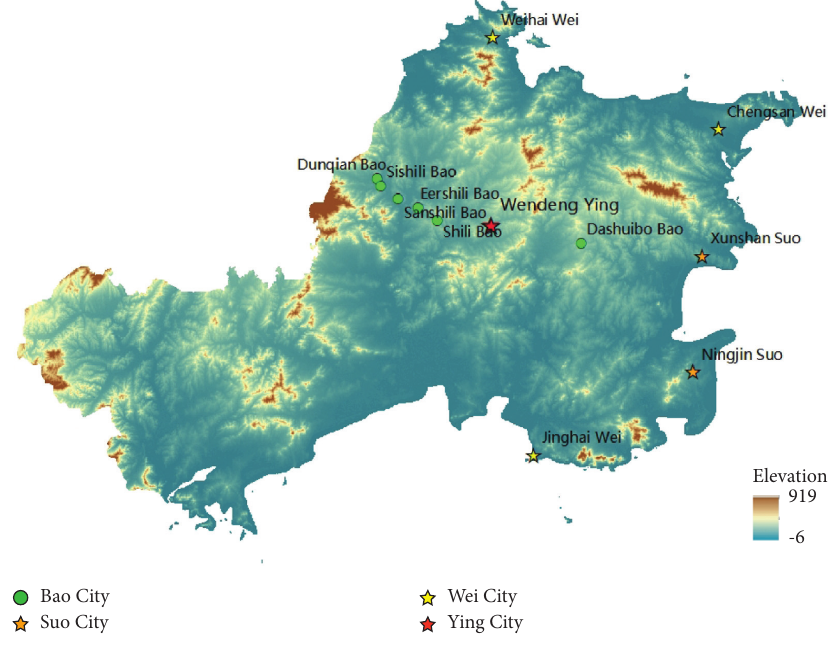
Figure 2: Data map of the cities in Weihai.